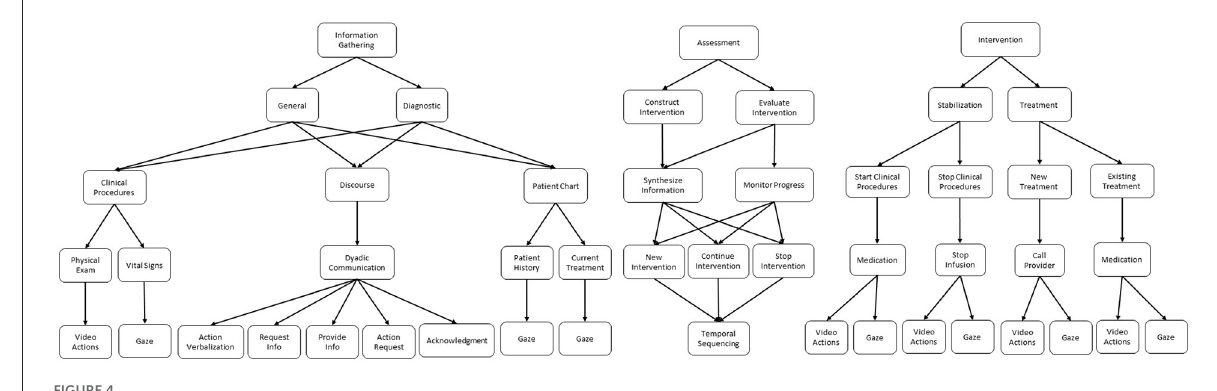
FIGURE4 Cognitive task model for the nursing simulation domain.